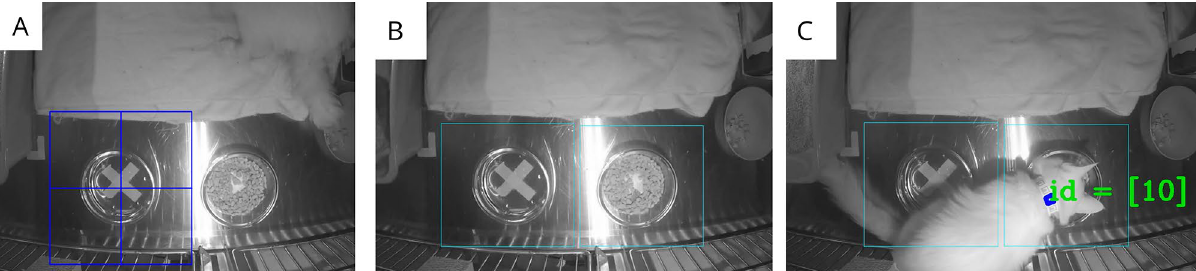
Figure 3. ( A ) A region of interest (ROI) is manually drawn on the video output. ( B ) Two regions of interest are drawn around resources of interest, including a water and food bowl. ( C ) A marker for ID 10 is detected in the food bowl